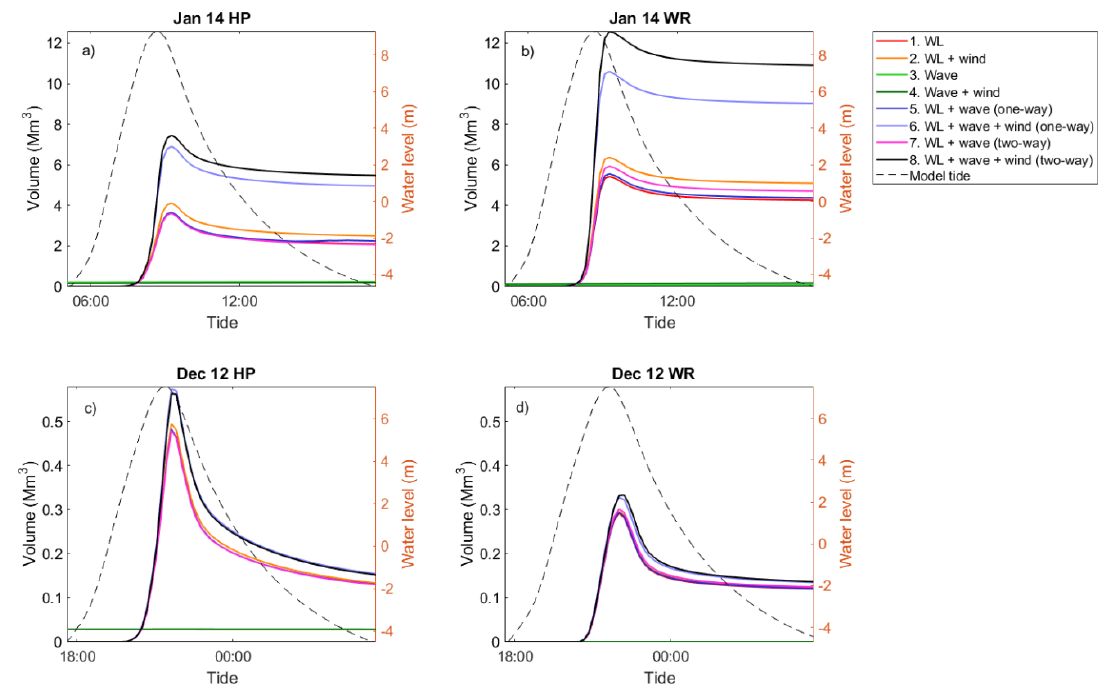
Figure 7. Change in volume of inundation (Mm 3 ) in the Oldbury model domain for January 14 forced by ( a ) HP and ( b ) WR; and December 12 forced by ( c ) HP and ( d ) WR. Modelled high tide from low water to low water is also shown (dashed line).